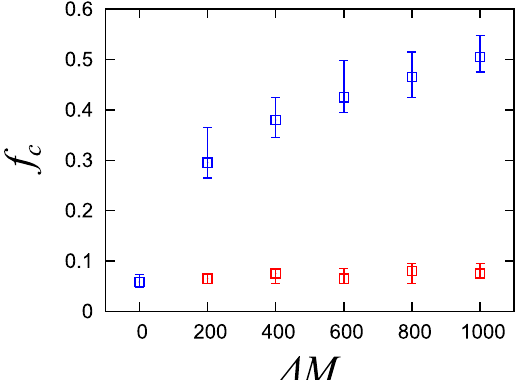
Figure 6. The number of doping links Δ M vs, the median for the percolation transition point f c in the extended ring network. Red represents doped fat links and blue represents doped muscle links. The error bars indicate the interquartile range (IQR) for 100